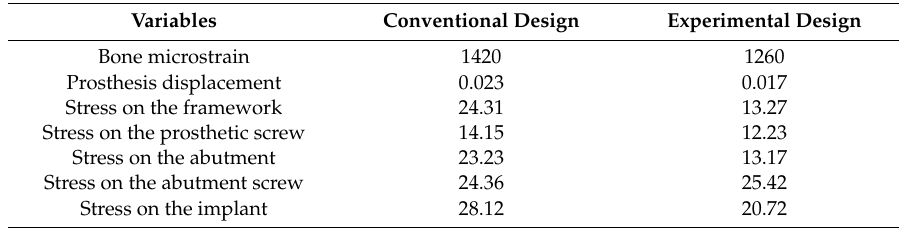
Table 2. Results in terms of bone microstrain ( µε ), prosthesis displacement (mm) and stress peak values (MPa) according to the